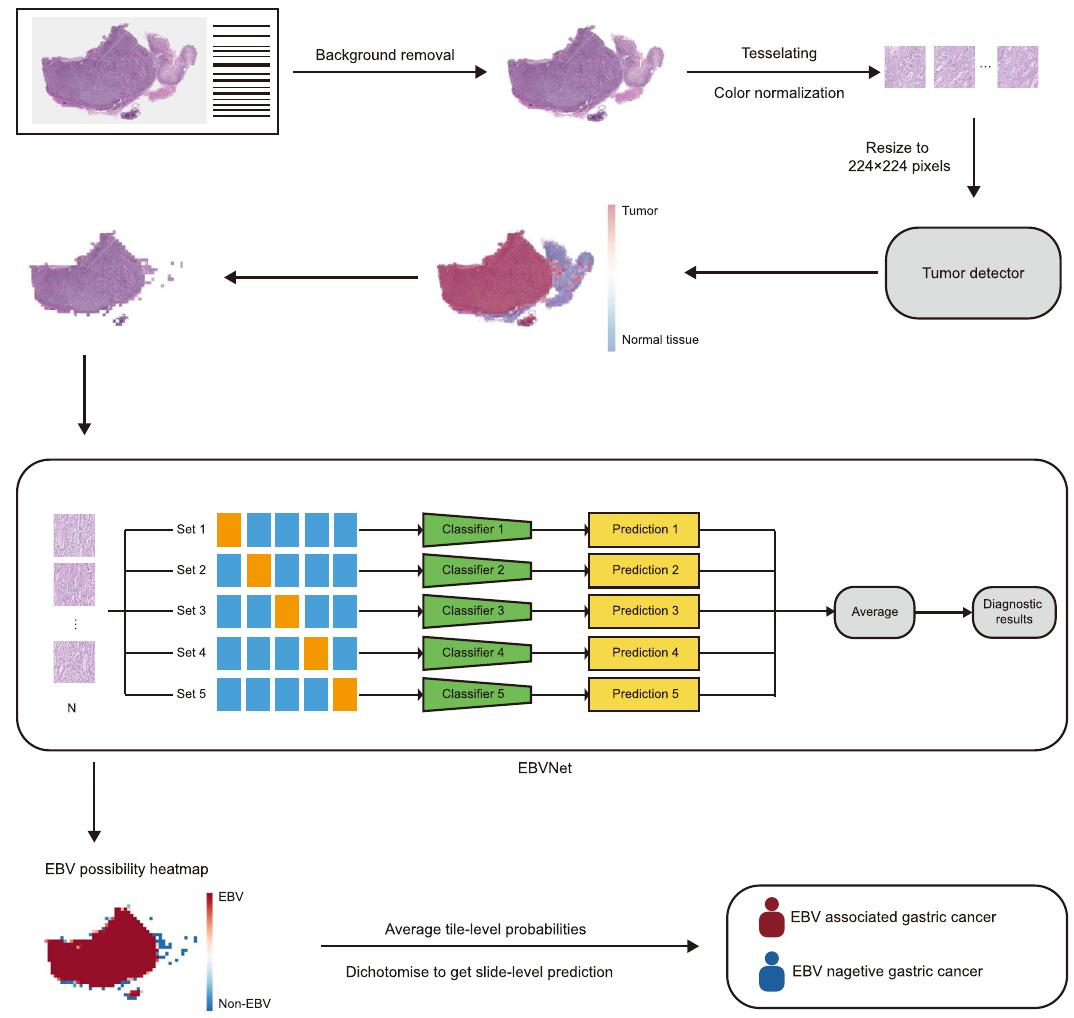
Fig. 1 The work fl ow of EBVNet for predicting EBV status with hematoxylin and eosin-stained WSIs. Each WSI was preprocessed and tessellated into non-overlapped tiles of ×10 magni fi cation. After color normalization, tiles were resized to 224 × 224 pixels and then input to the tumor detector. Only tiles from regions recognized as tumor were fed to EBVNet to get tile-level probabilities for EBV status. The fi ve well-trained individual classi fi ers were ensembled to form the EBVNet at the output layer of individual classi fi ers. The average probability outputs of the fi ve individual classi fi ers were used as the prediction of the ensembled model EBVNet. Tile-level probabilities were averaged to generate a slide-level probability of EBV status. EBV Epstein-Barr Virus, WSI whole slide